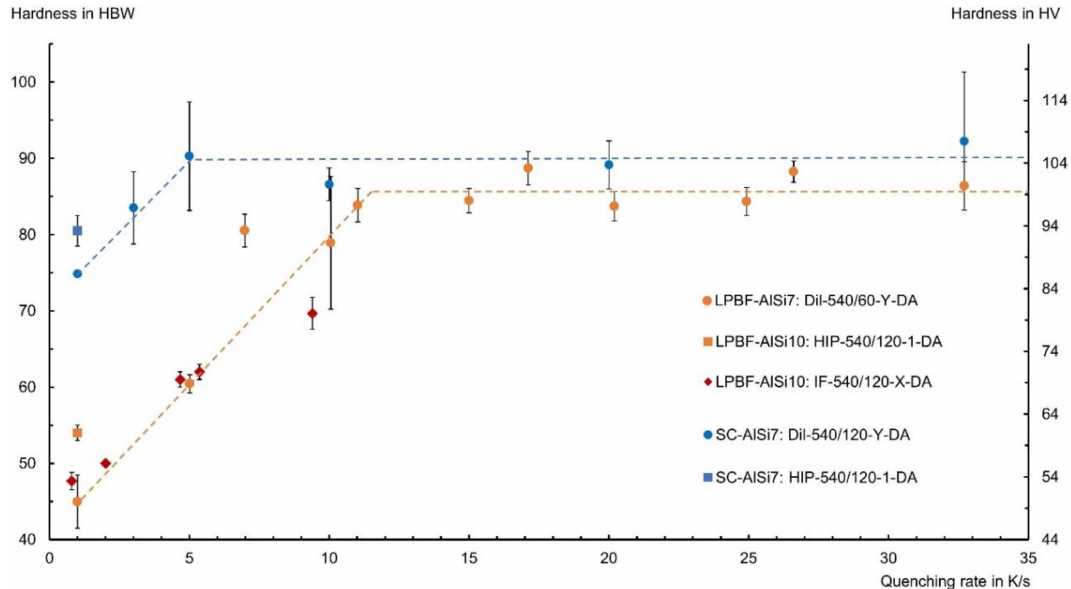
Figure 5. Hardness in dependence of the quenching rate after solution annealing followed by direct aging. The dashed levelling lines symbolize the quenching rate dependency of LPBF and SC samples. Denoted quenching rates ( x -axis) refer to the average cooling rate between 535 ◦ C and 200 ◦